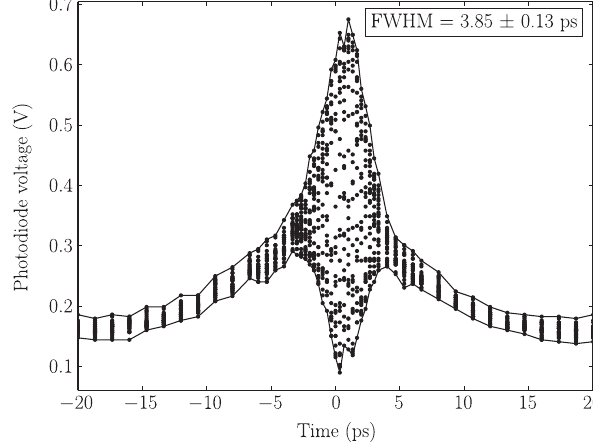
FIG. 10. Autocorrelation of the seed laser compressed without transmission through the final PCF amplification stage.